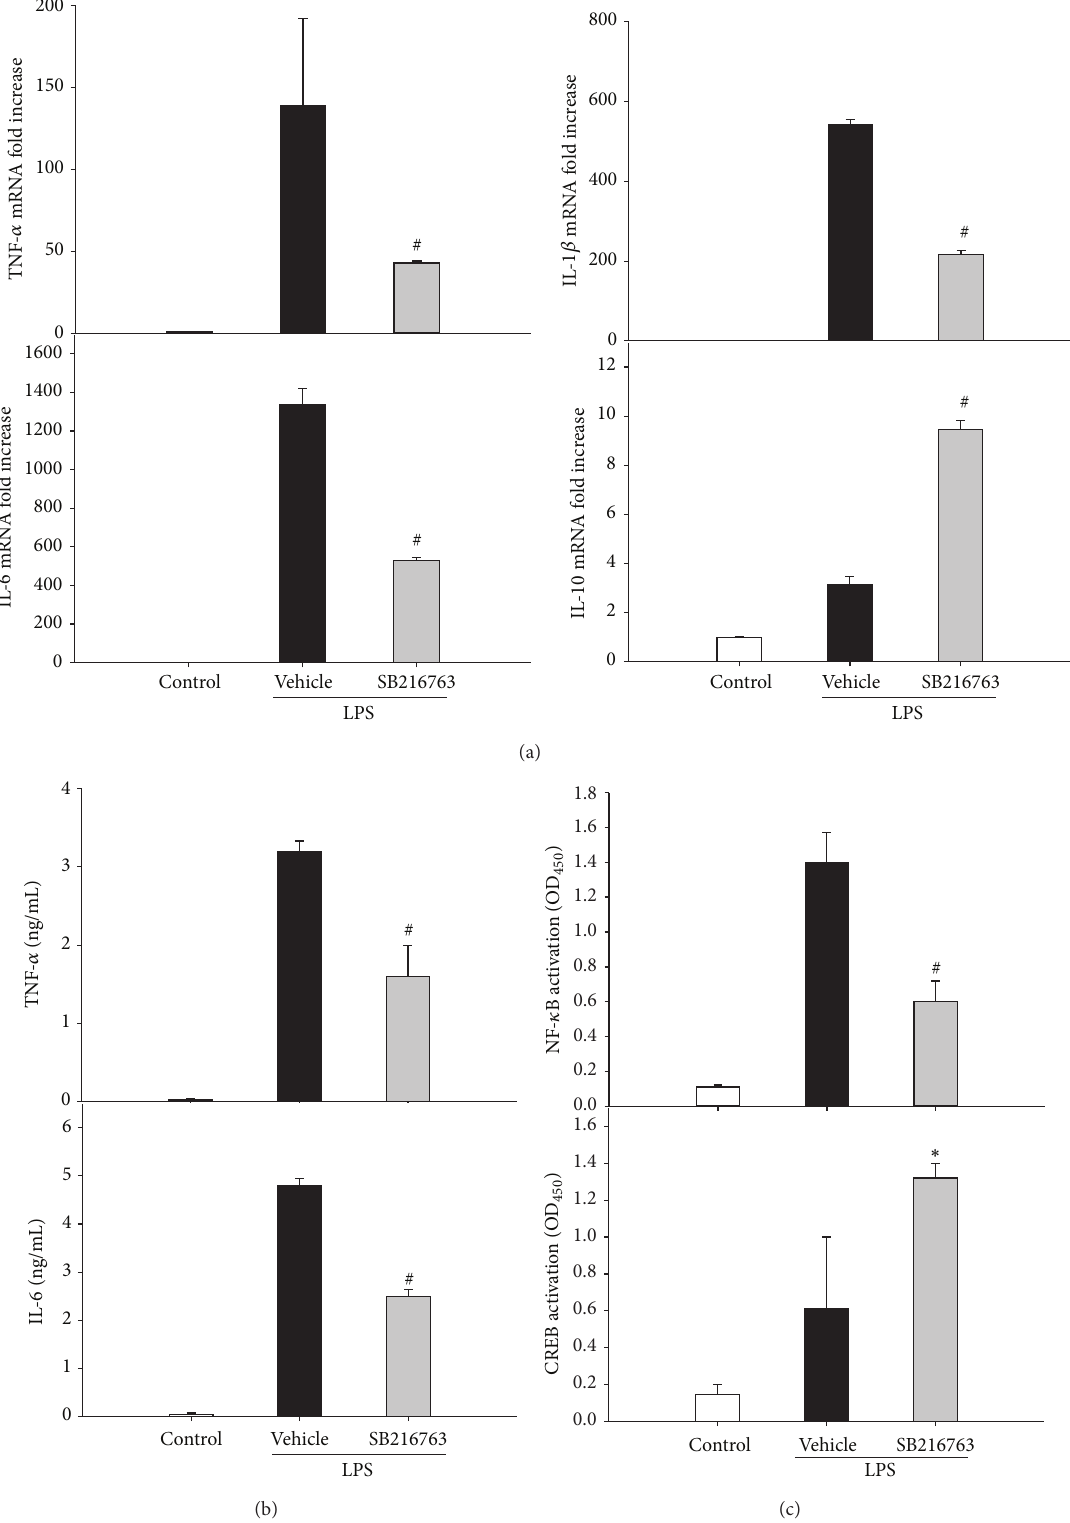
Figure 5: GSK-3 𝛽 inhibition reduces the proinflammatory cytokine expression in cultured macrophages stimulated by LPS. (a) RAW264.7 cells were stimulated with LPS for 6h in the absence or presence of SB216763 (10 𝜇 M). TNF- 𝛼 , IL-6, IL-1 𝛽 , and IL-10 mRNA expression levels were measured by quantitative PCR. (b) TNF- 𝛼 and IL-6 concentration in the cultured medium was measured by ELISA. (c) RAW264.7 cells were stimulated with LPS for 1h in the absence or presence of SB216763 (10 𝜇 M). NF- 𝜅 B activity, as well as CREB activity, was assessed. Data are shown as mean ± SD. 𝑛 = 5 per group. ∗ 𝑃 < 0.05 , # 𝑃 < 0.01 compared with vehicle-treated